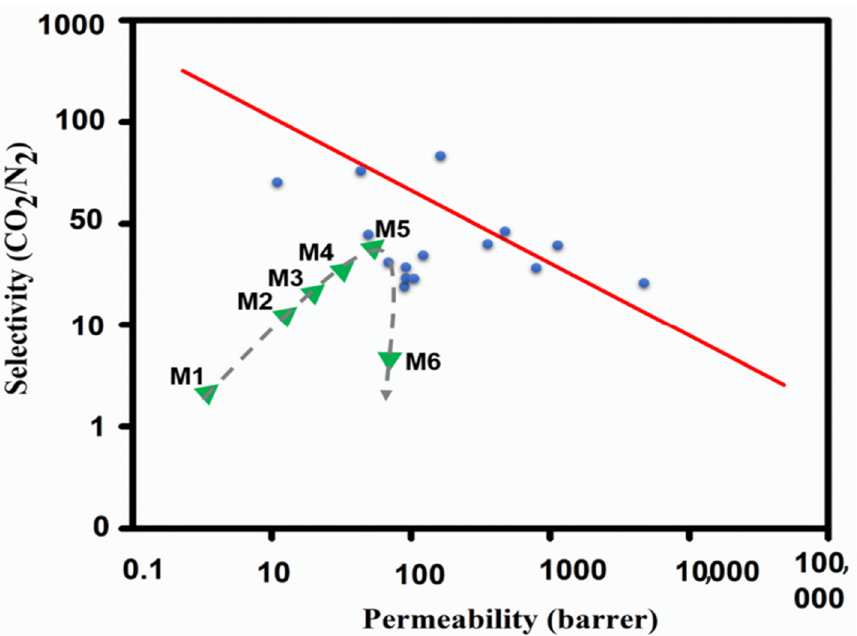
Figure 9. Robeson upper bound for CO 2 /N 2 separations of M1–M6 membranes (0–55 wt.% of MOF loading). The 2008 upper bound line illustrates the tradeoff between permeability and selectivity, adapted from Refs. [9,26].